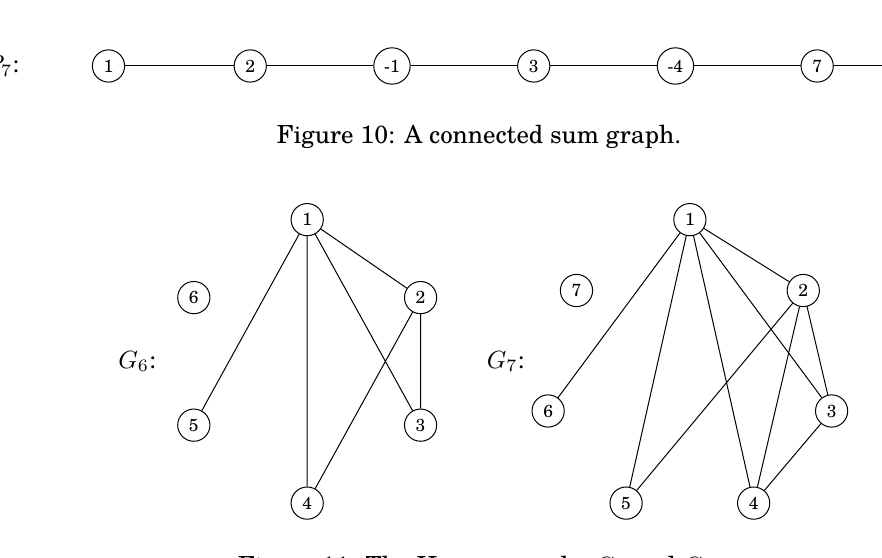
Figure 11: The Harary graphs G 6 and G 7